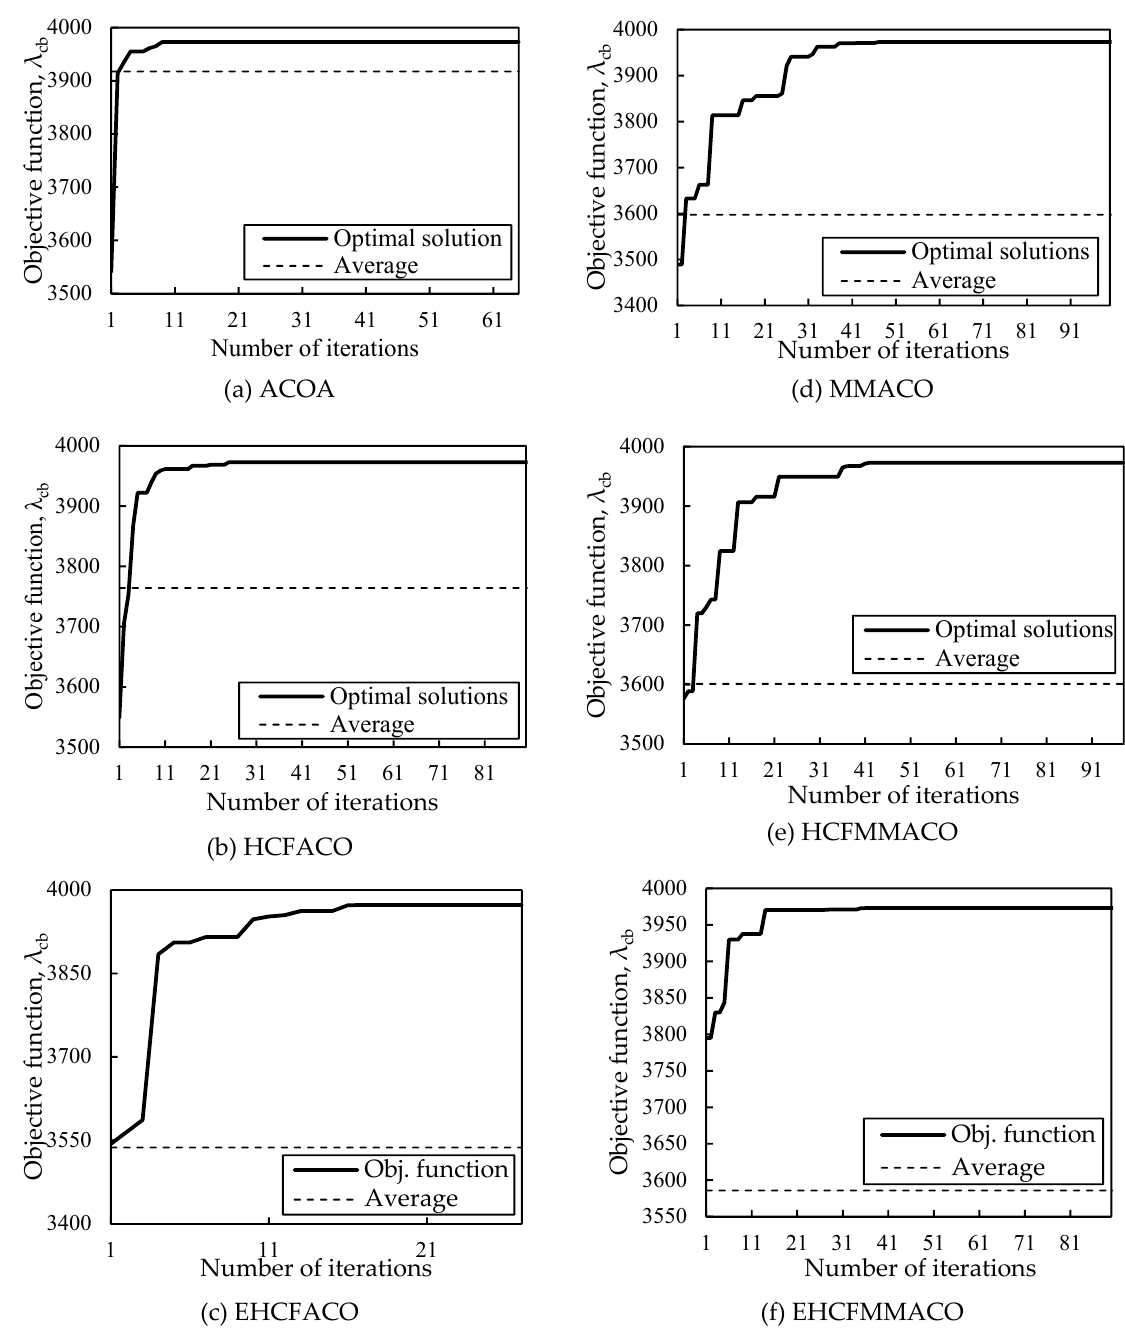
Figure 3. Solution convergence of ACO-MMACO and their Hyper-Cube Framework variants.